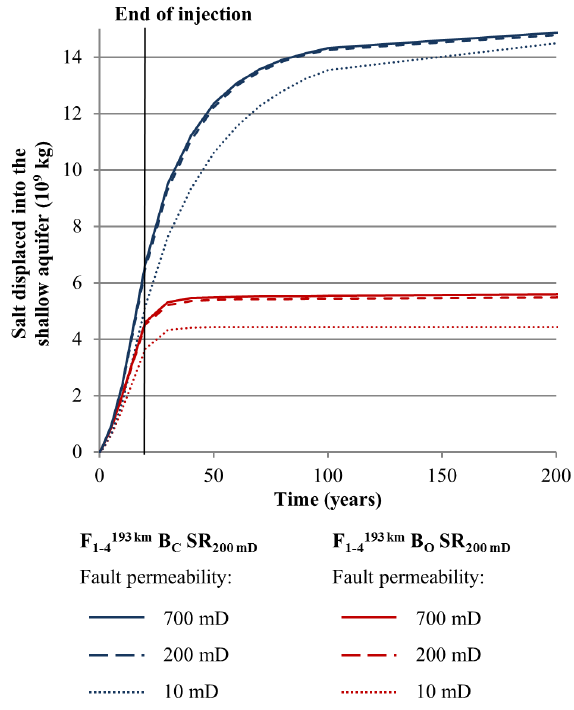
Figure 10. Salt mass displaced into the shallow aquifer assuming four open faults with varying permeability, a secondary overlying reservoir and open (red) or closed (blue) reservoir boundaries. The salt mass displaced into the shallow aquifer at the time of the injec- tion stop and thereafter is almost identical for a fault permeability higher than (solid lines) or equal (dashed lines) to the permeability of the secondary reservoir. If fault permeability is lower than that of the secondary reservoir (dotted lines), less salt is displaced into the shallow aquifer. Closed reservoir boundaries and low-permeable faults lead to retardation in mass flow (blue dotted